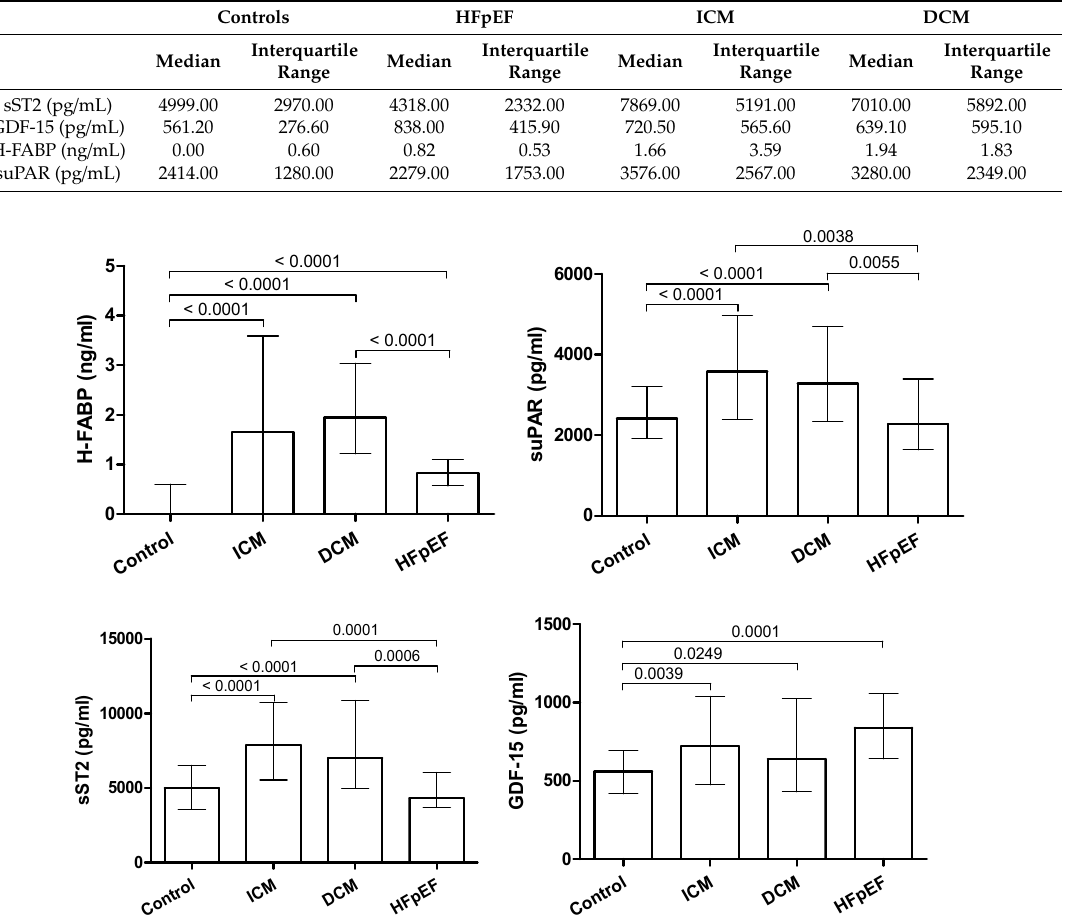
Figure 1. Comparison of biomarker levels between control group, HFpEF, ICM, and DCM patients (median + IQR).